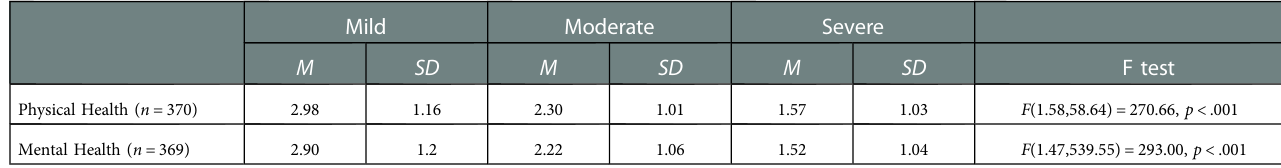
TABLE 4 Differences in attitudes to DI for mild, moderate and severe mental and physical health conditions.